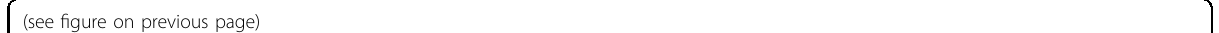
Fig. 1 Impact of PD-L1 interaction on T-cell functionality and characterization of anti-CD19 and anti-CD22 CAR T cells with PD-1-CD28 fusion protein. A PD-L1 expression on Nalm-16 cells was analyzed 24 h after stimulation with IFN- γ and TNF- α . B Primary ALL blasts from 31 different pediatric BCP-ALL patients were stimulated with IFN- γ and TNF- α for 24 h. Pie chart shows percentage of PD-L1-inducible vs. PD-L1-non-inducible samples (left panel). Surface PD-L1 expression in inducible patients ( n = 16) is shown in the right panel (fold-change of stimulated sample vs. unstimulated sample). C Conventional second-generation CAR T cells were co-cultured with CD19 + and CD19 + /PD-L1 + Daudi cells. Percentage of intracellular IFN- γ + in CAR T cells was analyzed 24 h later. D 19_BB_3z T cells were co-cultured with Daudi cells for 24 h and co-culture supernatant was analyzed for concentration of IFN- γ , IL-2 and TNF- α in a fl ow-cytometry-based assay. E Schematic illustration of CAR constructs and negative control (19t). F 19_3z_PD-1_28 CAR T cells were co-cultured with CD19 - /PD-L1 - , CD19 - /PD-L1 + and CD19 + /PD-L1 + target cells (transduced